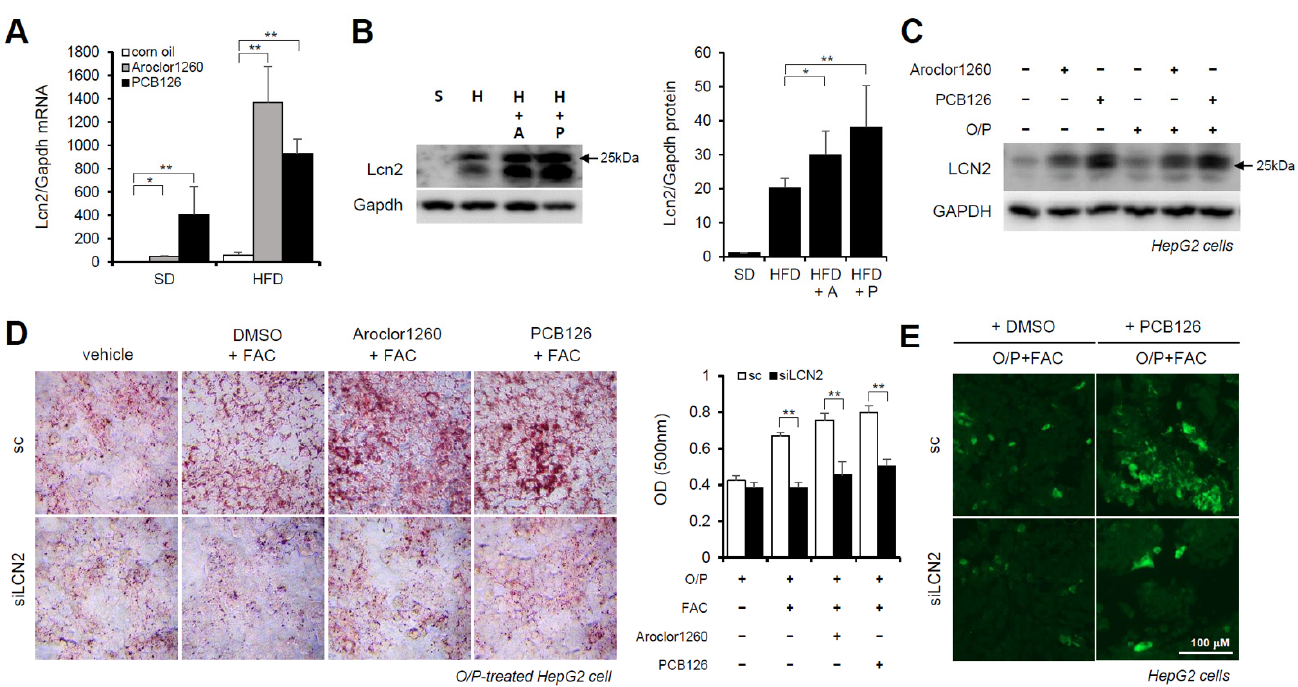
Figure 6. Hepatic LCN2 mediates PCB-induced hepatic lipid and iron accumulation. ( A ) Real-time PCR was performed to detect mouse LCN2 in liver tissues from Aroclor1260- or PCB126-injected mice fed either a SD or HFD. The values represent the mean ± SD, n = six to eight mice per group. * p < 0.05 and ** p < 0.01. ( B ) Western blot analysis was performed to quantify and detect mouse LCN2 in liver tissues from Aroclor1260- or PCB126-injected mice fed a HFD. ( C ) Western blot analysis was performed to assess human LCN2 in HepG2 cells cotreated with 20 μ M Aroclor1260 or 10 μ M PCB126 and treated with either BSA or O/P (250 μ M). ( D ) ORO staining and quantification showing that silencing human LCN2 attenuated PCB-induced hepatic lipid accumulation in HepG2 cells. All values represent the mean ± SD, n = 4. **, p < 0.01 compared with the experimental control. ( E ) Detection of intracellular ferrous ions (Fe 2+ ) using the fluorescent probe FerroFarRed showing that silencing human LCN2 reduced PCB126-induced hepatic iron accumulation in O/P-treated HepG2 cells. Scale bar: 100 μ m. S, SD; H, HFD; A, Aroclor1260; P, PCB126.